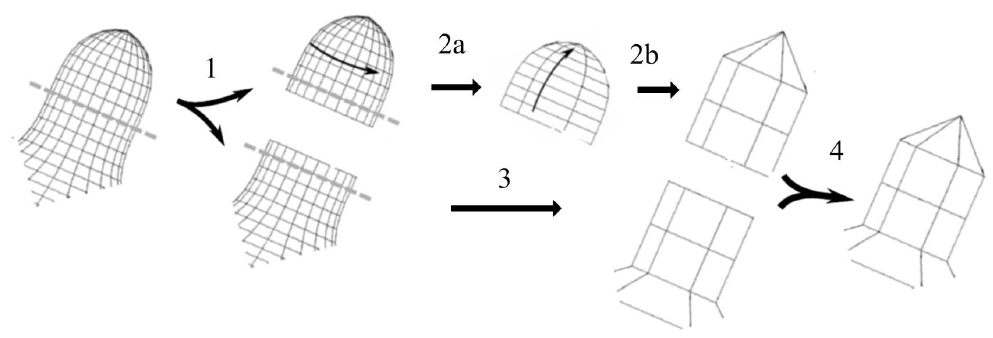
Figure 7. Performing the compound wavelet analysis: (1) separating the input mesh and per- form wavelet analysis in the overlap region; (2a) decomposing the polar structure in circular layer; (2b) decomposing the polar structure in radial layer; (3) decomposing the remainder. (4) Joining the resulted meshes after removal of overlapping facets.